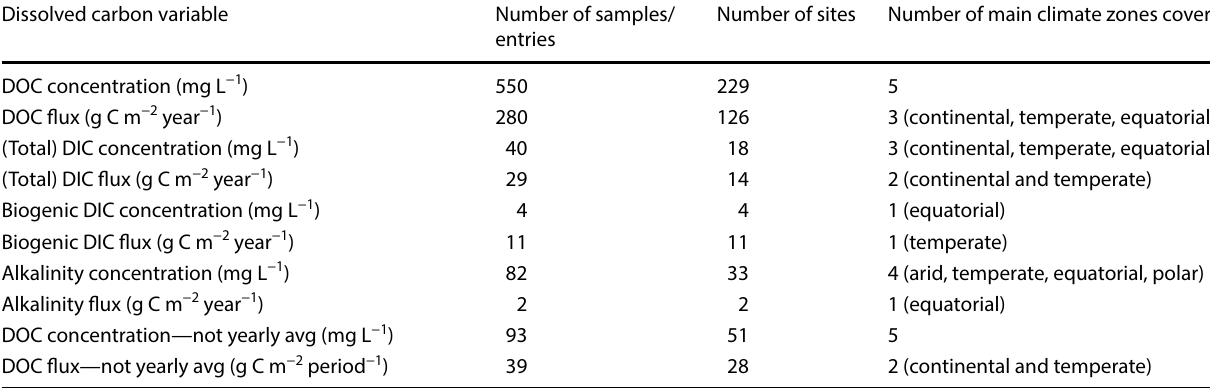
Table 1 Number of entries and sampling sites the in database for all carbon leaching variables, and their coverage over all main climate zones Dissolved carbon